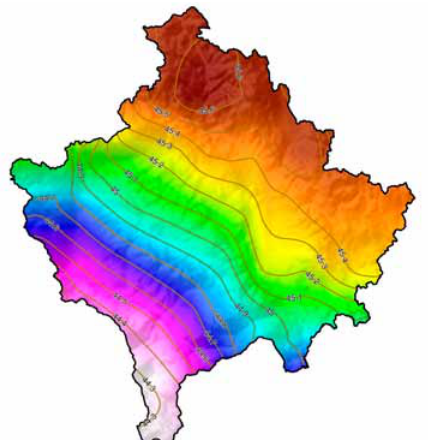
Fig. 6. Final Kosovo geoid model determined by DFHRS concept